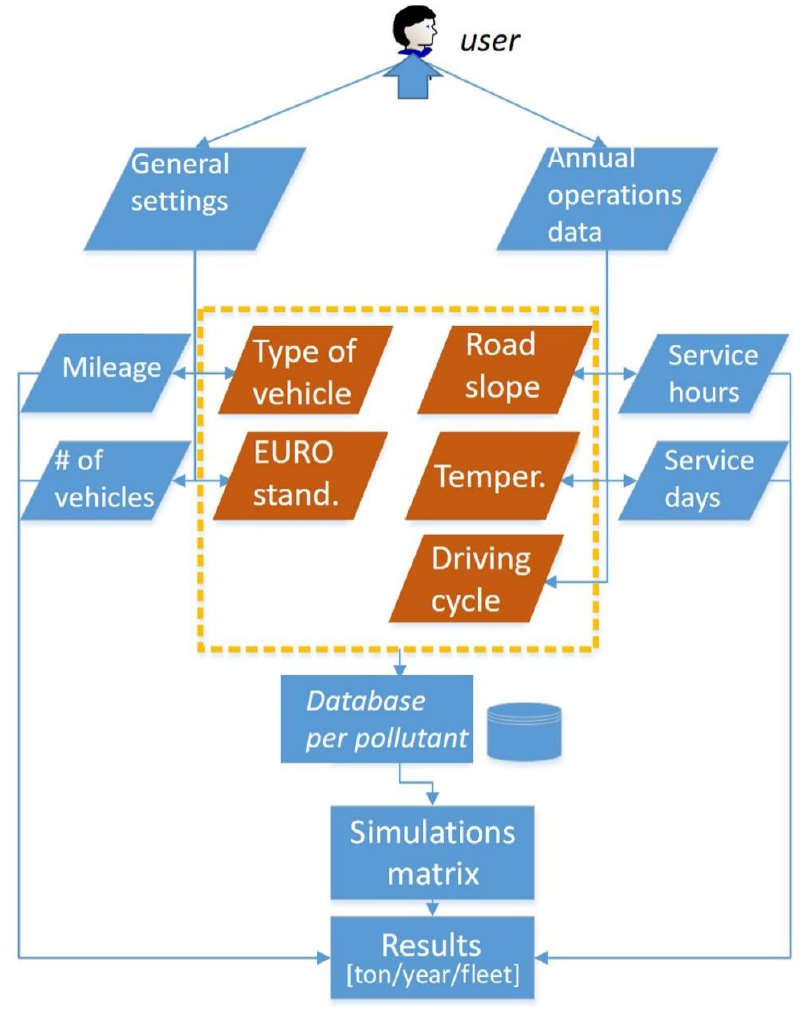
Figure 6. The software interface concept.